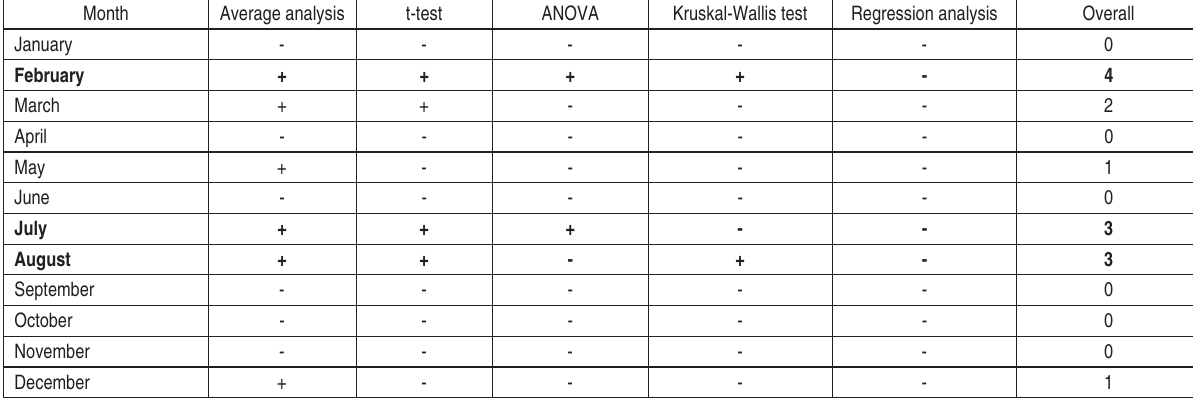
Table 4. Anomalies by month for the UX futures